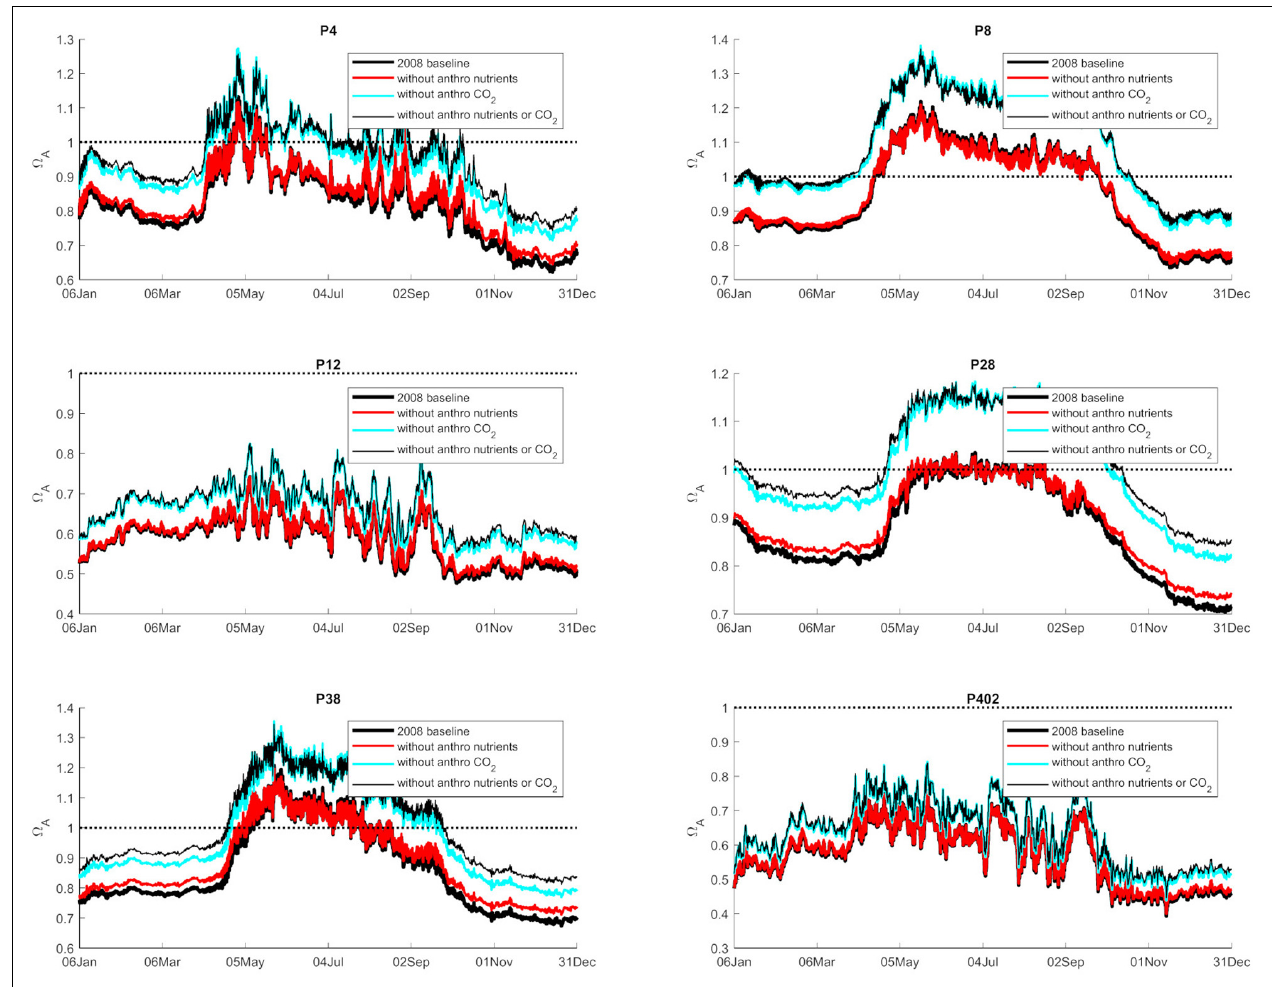
FIGURE 3 | Graphical representation of the average annual 0–100 m values of (cid:127) ar (2008 baseline), and separated as a contribution to nutrients, atmospheric CO 2 , and both at six selected stations in Puget Sound (P4, P8, P12, P28, P38, P402 with locations shown in Figure 1